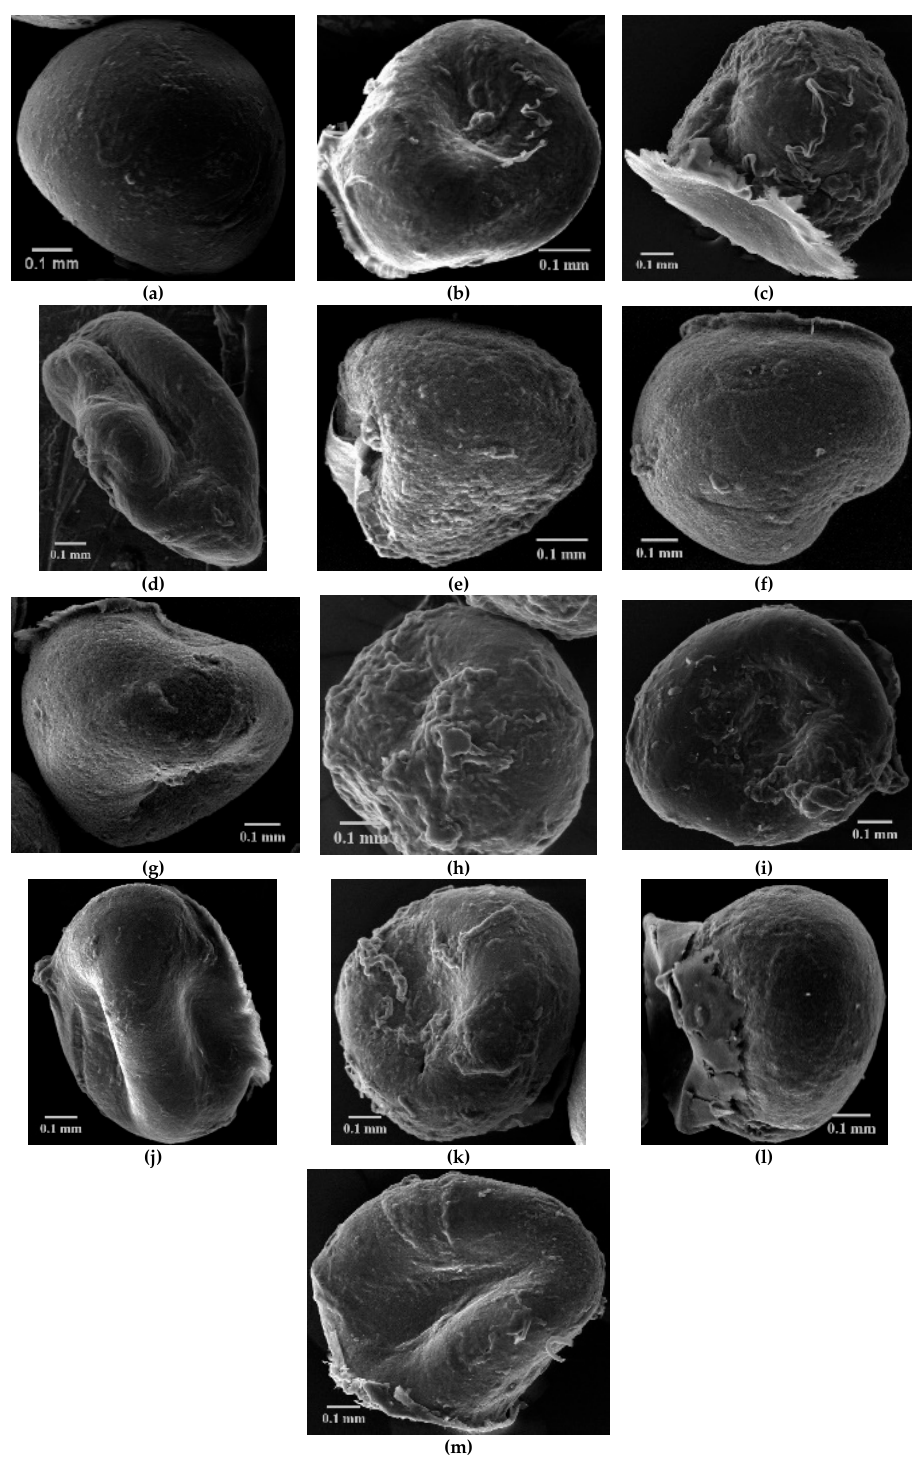
Figure 2. Scanning electron microscope (SEM) images for CS and CS-XTDs microparticles ( a : CS, b : CS-6c 1 , c : CS-6c 2 , d : CS-6c 3 , e : CS-6e 1 , f : CS-6e 2 , g : CS-6e 3 , h : CS-6f 1 , i : CS-6f 2 , j : CS-6f 3 , k : CS-6k 1 , l : CS-6k 2 , m : CS-6k 3 ); 1 = 3 mg/mL, 2 = 4 mg/mL, 3 = 5